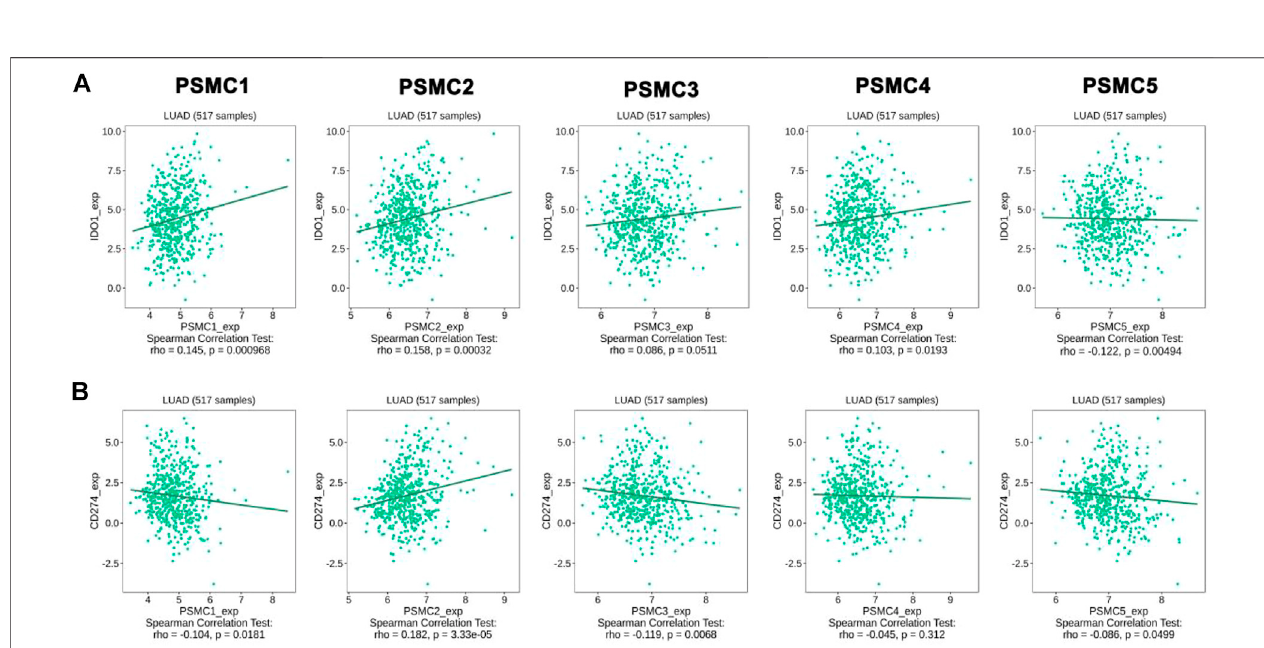
FIGURE 8 | Association between the PSMC expression and the in fi ltration levels of IDO1 (A) and CD274 (B) in LUAD tissues. Signi fi cant positive and negative correlations were observed in between PSMC expression levels and immunomodulator expression levels.